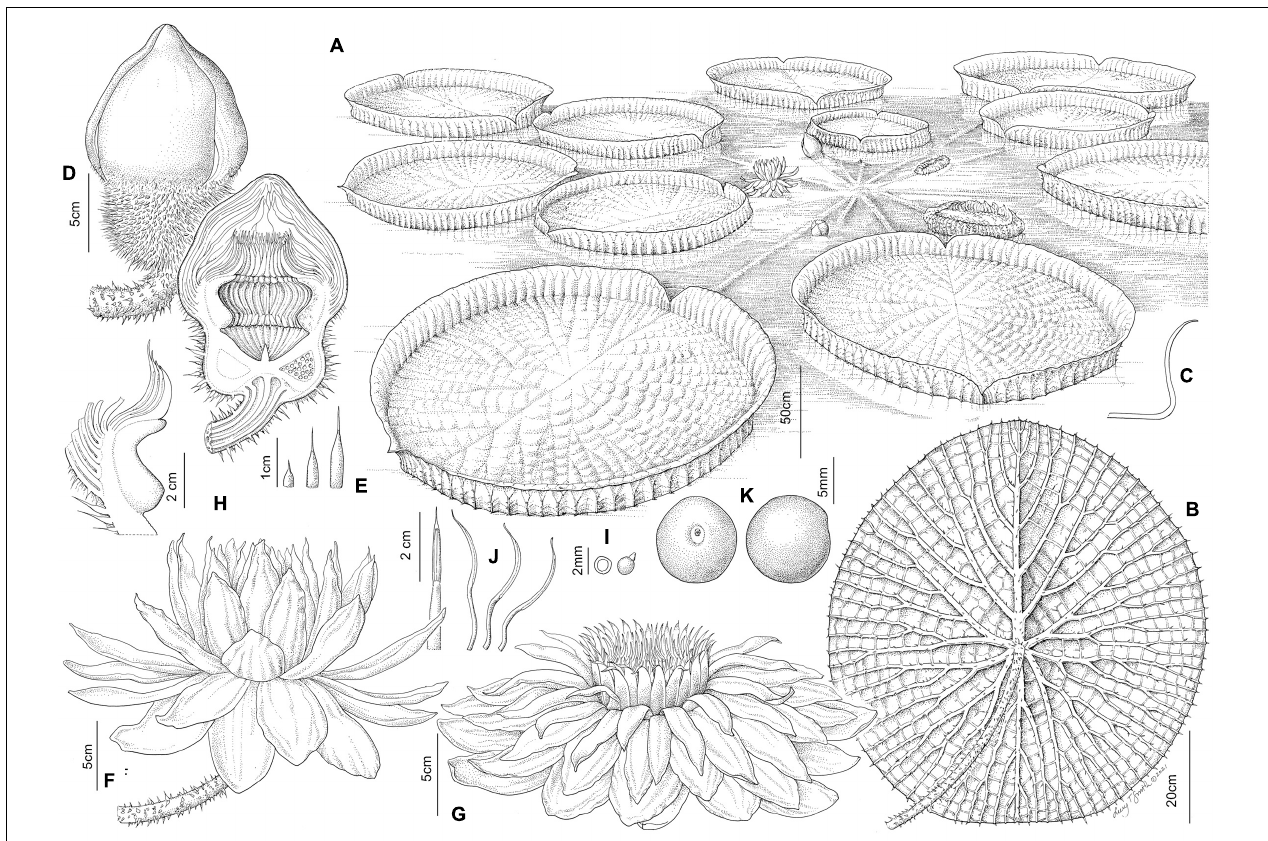
FIGURE 6 | Victoria cruziana (A) habit, (B) abaxial leaf, (C) leaf rim profiles, (D) bud, whole and LS, (E) flower prickles, (F) first night flower, (G) second night flower, (H) carpellary appendages and tepal, staminode attachments; (I) ovule, whole and LS, (J) stamens, (K) seed. ( A–E, G–K , cultivated at RBG Kew, F cult. Denver Botanic Gardens). Illustration: Lucy T.